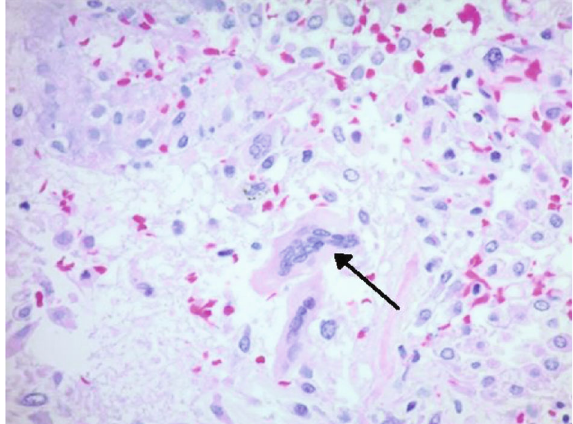
Figure 2: 40x magni fi cation, H&E stain, with multinucleated giant cell at